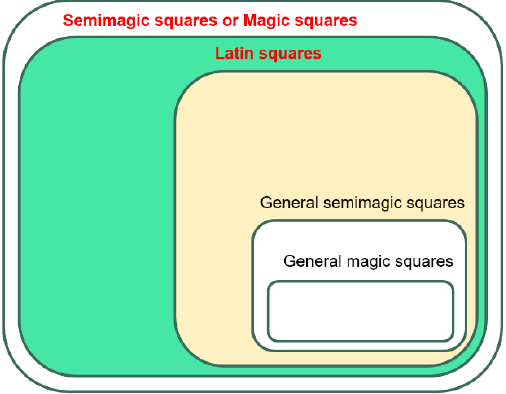
Figure 2. Sets and subsets of magic squares.